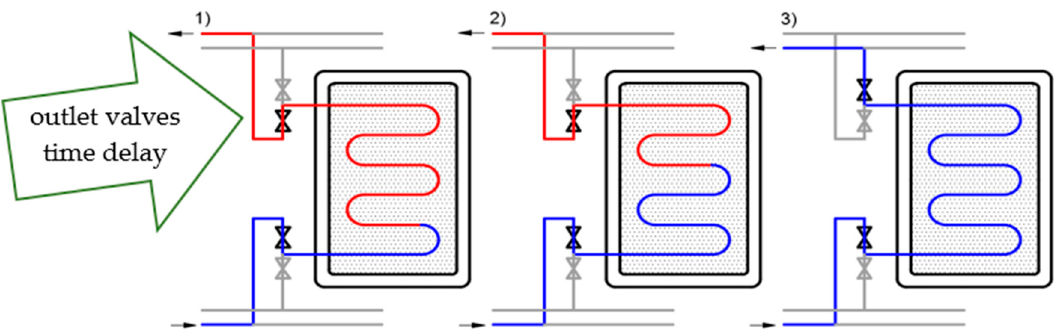
Figure 7. New control system: Switching the bed from heating to cooling mode. ( 1 ) Switching inlet valve. ( 2 ) The discharge of the hot water from the adsorber to hot water cycle. ( 3 ) Switching outlet valve.